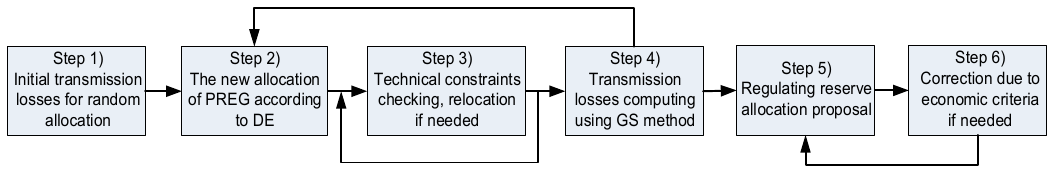
Figure 2. Block diagram for optimal allocation of regulating power.